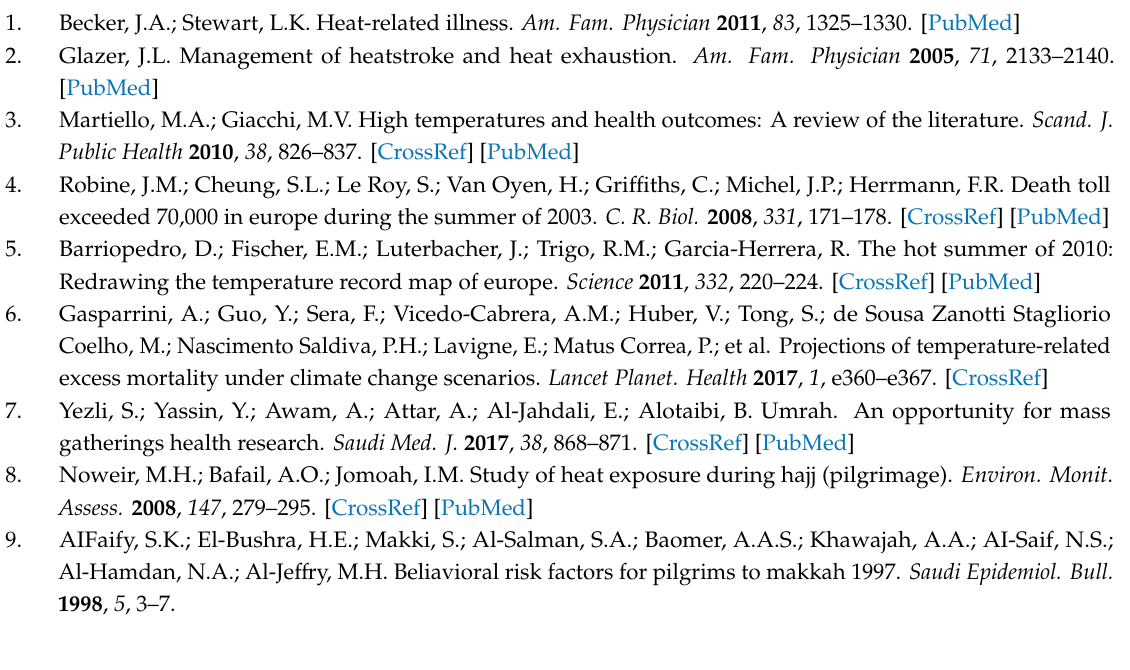
Table S1: Knowledge, attitude and practice of pilgrims regarding heat-related illnesses. Author Contributions: S.Y., A.M. and Y.Y. were involved in the conception, design and planning of the